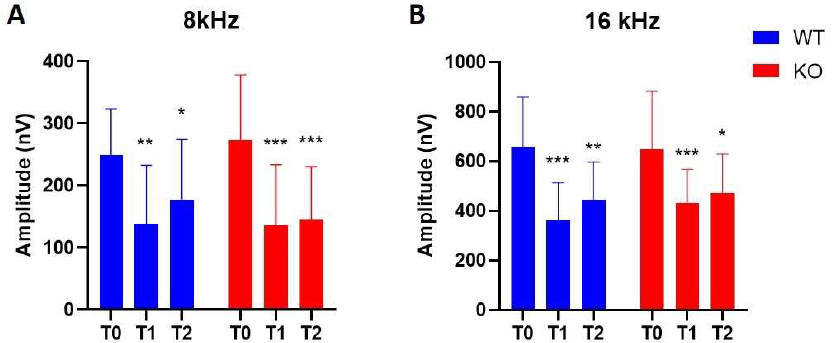
Figure 5. Wave I amplitudes of Coch −/− ( n = 13 ) and Coch +/+ mice ( n = 13 ) at different timepoints (T0 = baseline, T1 = 48 h post-noise, T2 = one-week post-noise) at 8 kHz ( A ), and 16 kHz ( B ). Data are represented as mean with SD. * indicates p < 0.05, ** indicates p < 0.01, *** indicates p < 0.001.